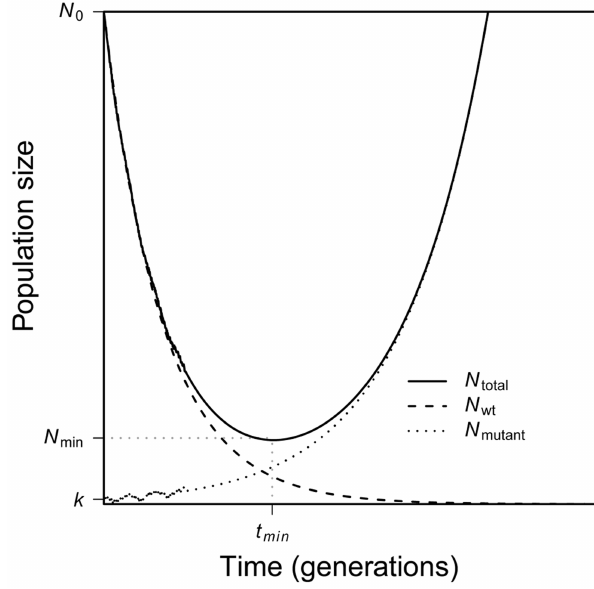
Figure 1. A schematic of evolutionary rescue. Following an environmental change, a population begins to decline as the wildtype suffers a fitness less than one. A rare mutant allele with fitness greater than one may increase in frequency, saving the population from extinction. Together, the two genotypes yield a characteristic U-shaped curve of total population size through